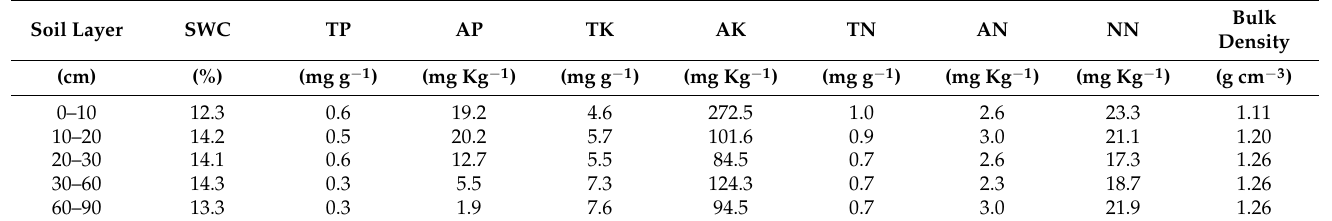
Table 1. Soil physicochemical properties before seeding of lucerne and grasses at the experimental